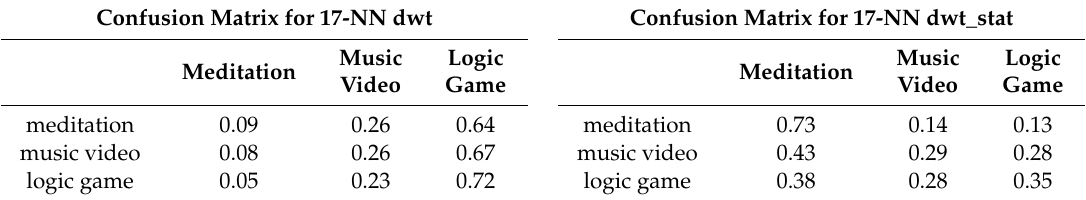
Table 5. Normalized confusion matrix for the 17-NN classifier and the dwt feature extraction scheme (left). Normalized confusion matrix for the 17-NN classifier and the dwt_stat feature extraction scheme